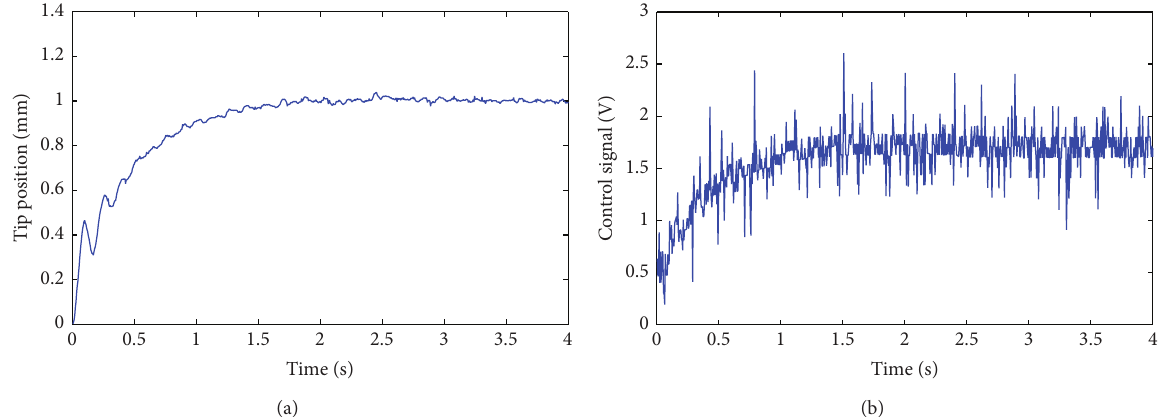
Figure 12: Step response of the closed-loop experimental system with the added mass using the fractional-order controller: (a) tip position, (b) control